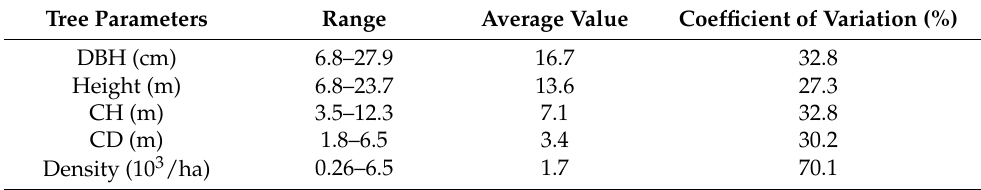
Table 1. The statistical information of CD values in ground-measured